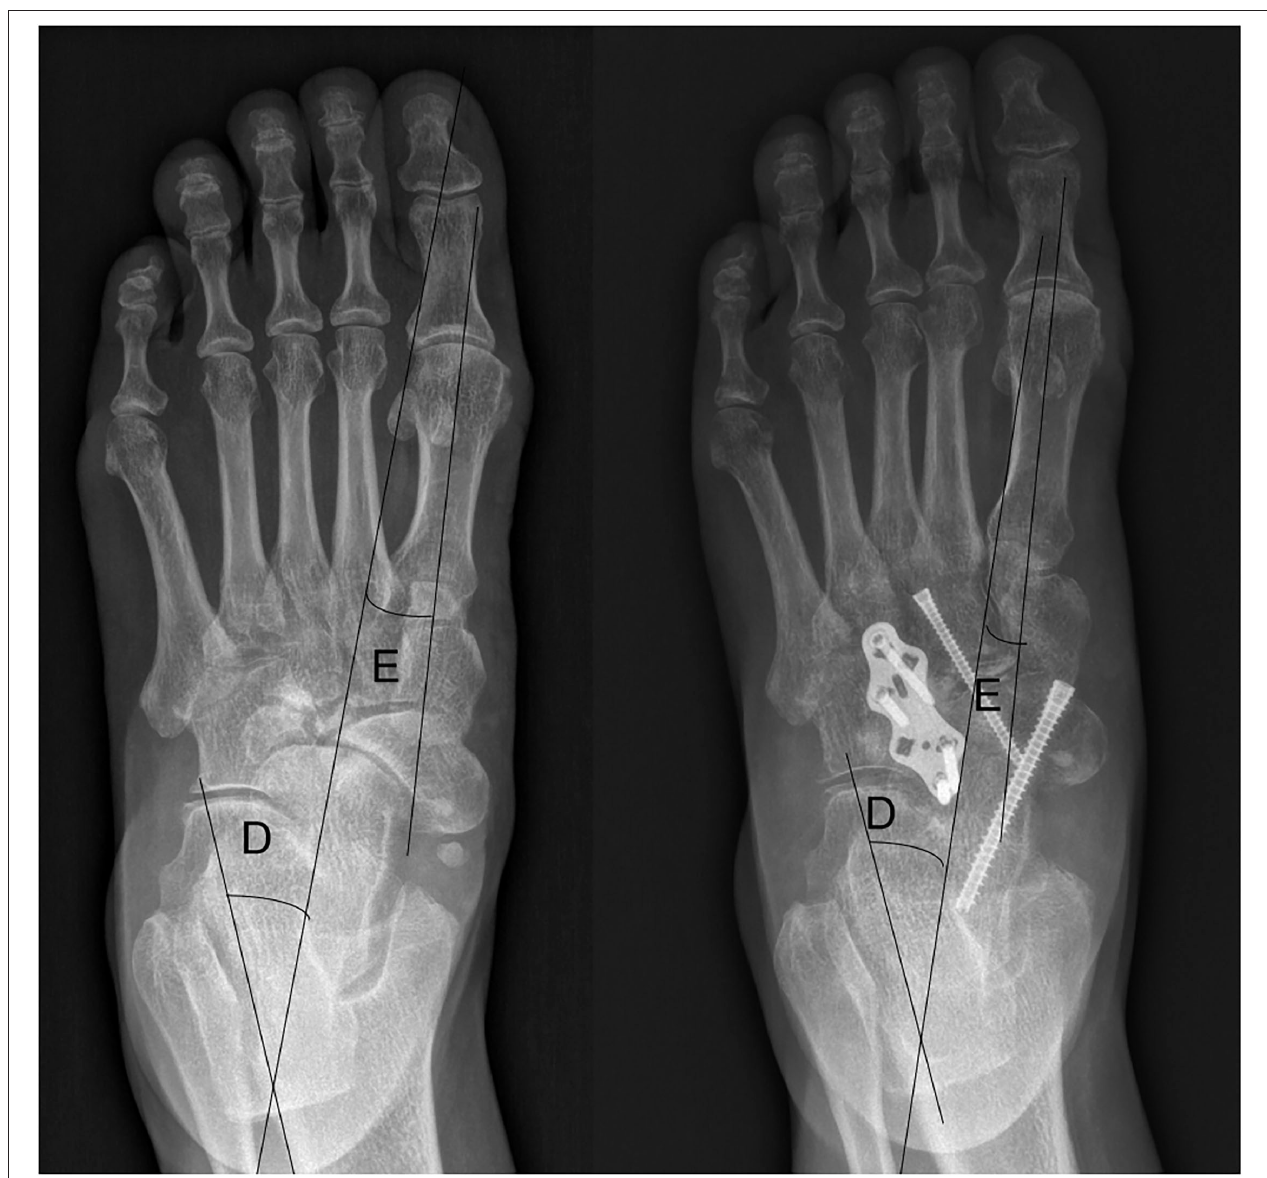
FIGURE 2 | Weight-bearing anteroposterior plain radiograph in a case that underwent TNC arthrodesis. (D) The talocalcaneal angle (TCA ap). (E) The talar–first metatarsal angle (TM ap, abduction = positive value, adduction = negative value).